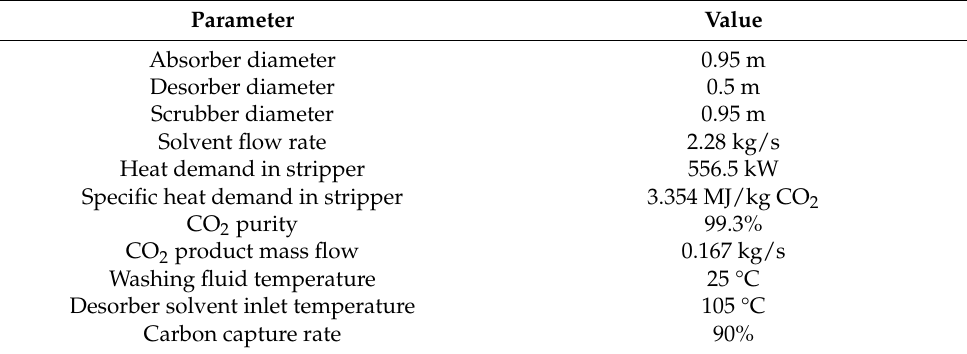
Table 6. Major simulation results for the design of the amine scrubbing